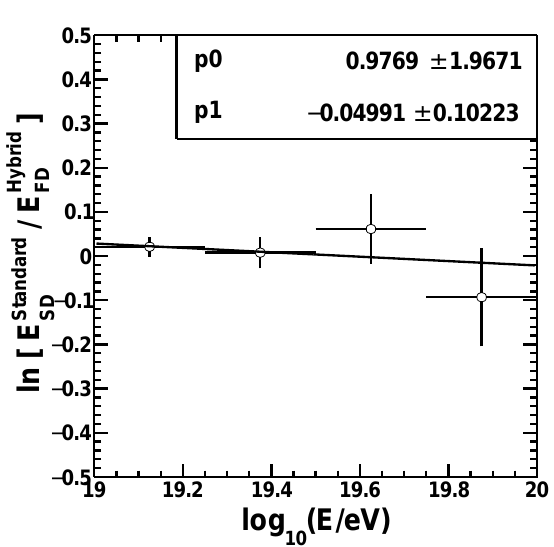
Figure 4. Natural log of the ratio of the calibrated surface de- tector energy to the fluorescence detector energy, plotted ver- sus energy. A fit to a straight line gives a slope of -0.05 that is within its fitting uncertainty of 0.10, indicating that there is no non-linearity of the SD energy with respect to the